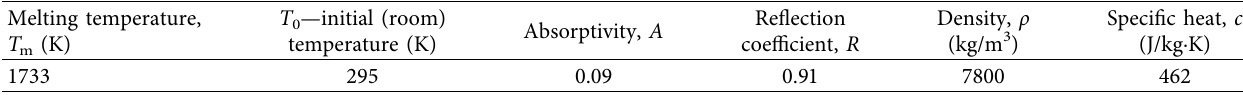
Table 5: Physical properties of carbon steel [25].